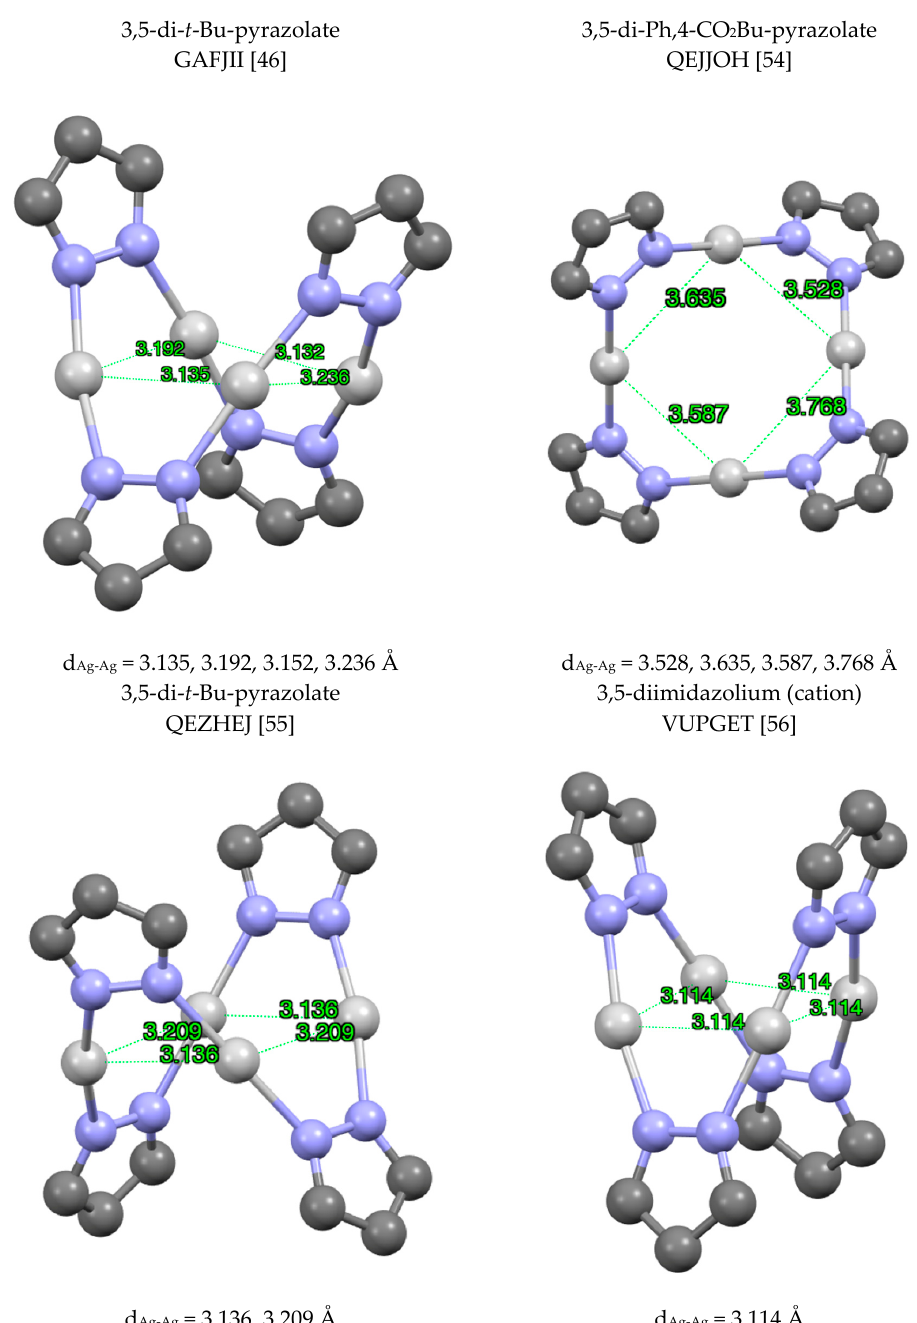
Figure 7. Different structures of (pzAg) 4 complexes. Only the silver atoms and the pyrazolate rings are represented. The four examples are very similar but different views have been used.